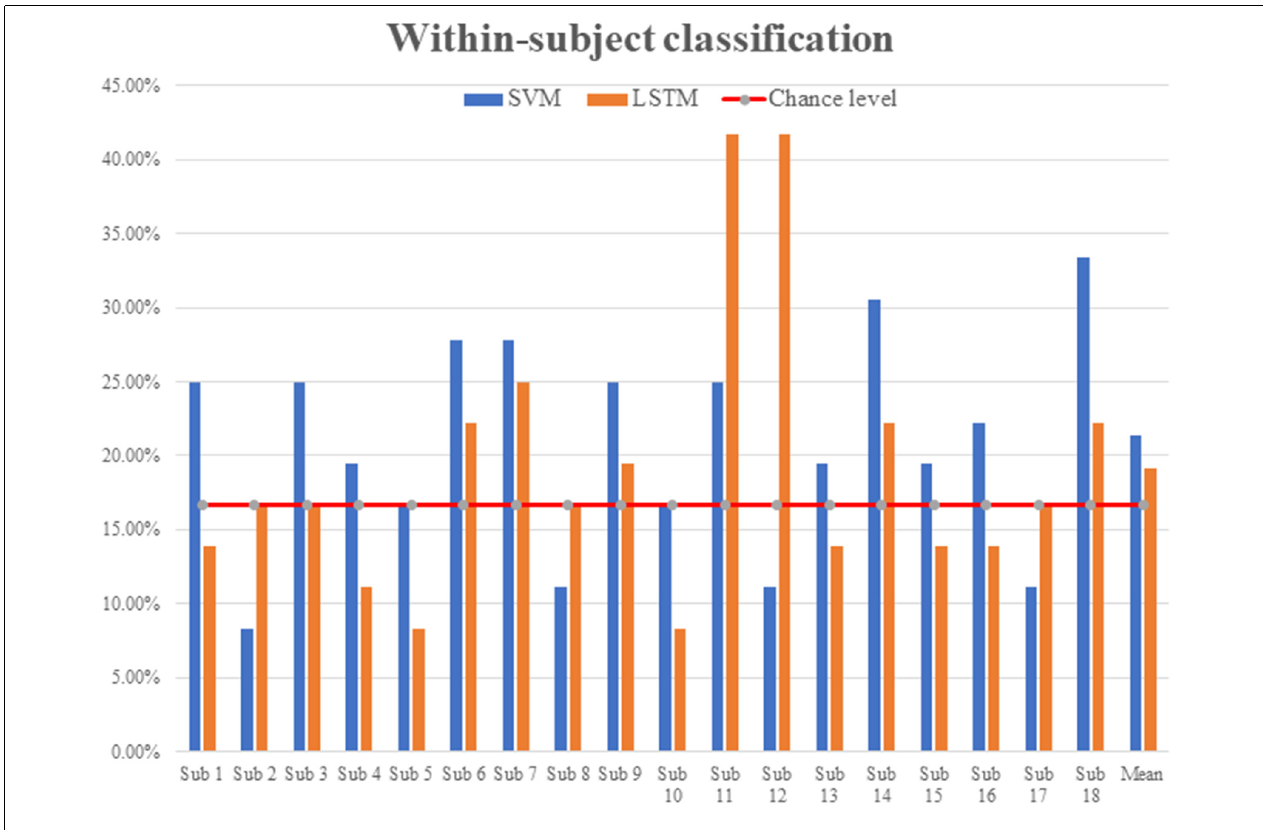
FIGURE 3 | Within-subject classification accuracies (SVM vs.